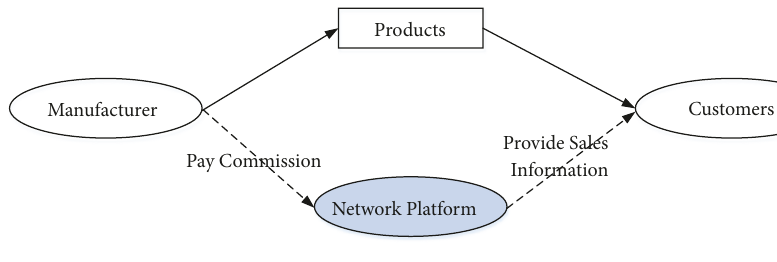
Figure 1: E-supply chain